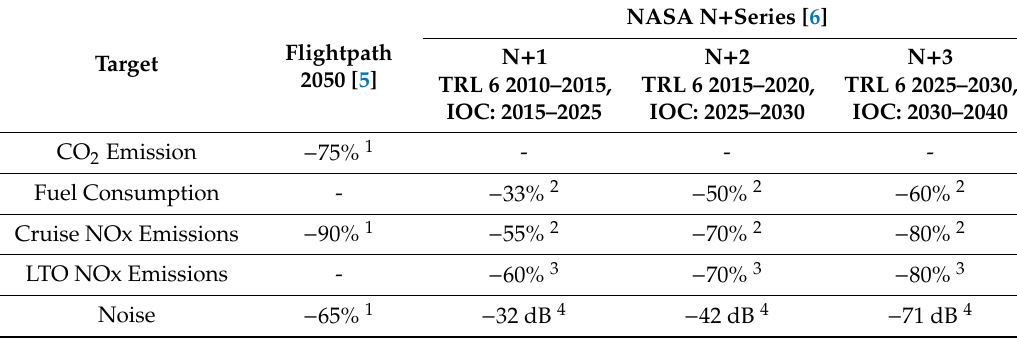
Table 1. Environmental